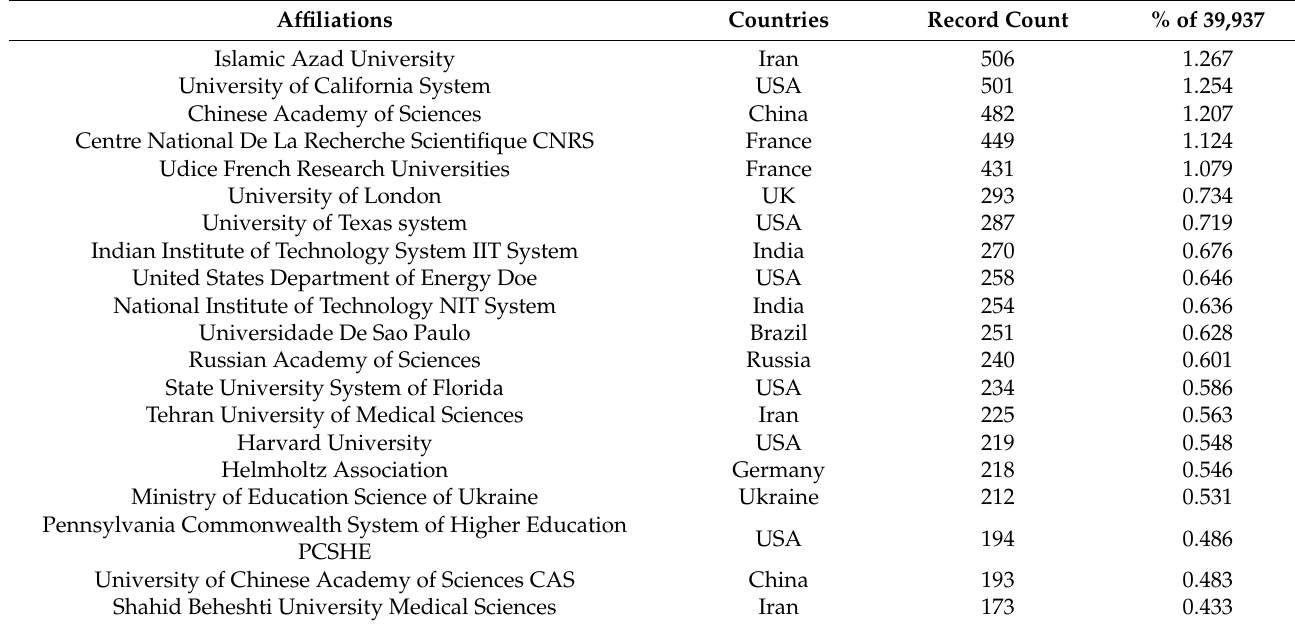
Table 10. Top 20 Institutions/Organizations based on the number of publications for the years